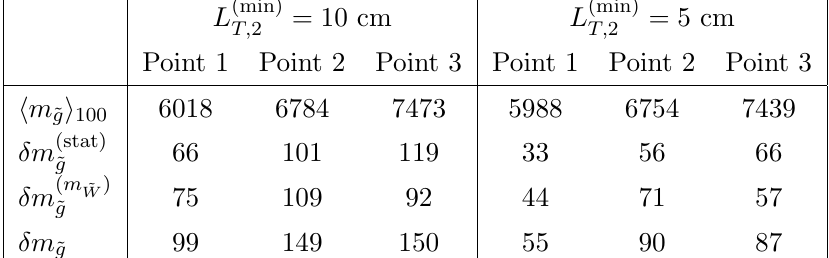
Figure 12 . Distribution of m (rec) in a single experiment with the integrated luminosity of L = 30 ab (cid:0) 1 .